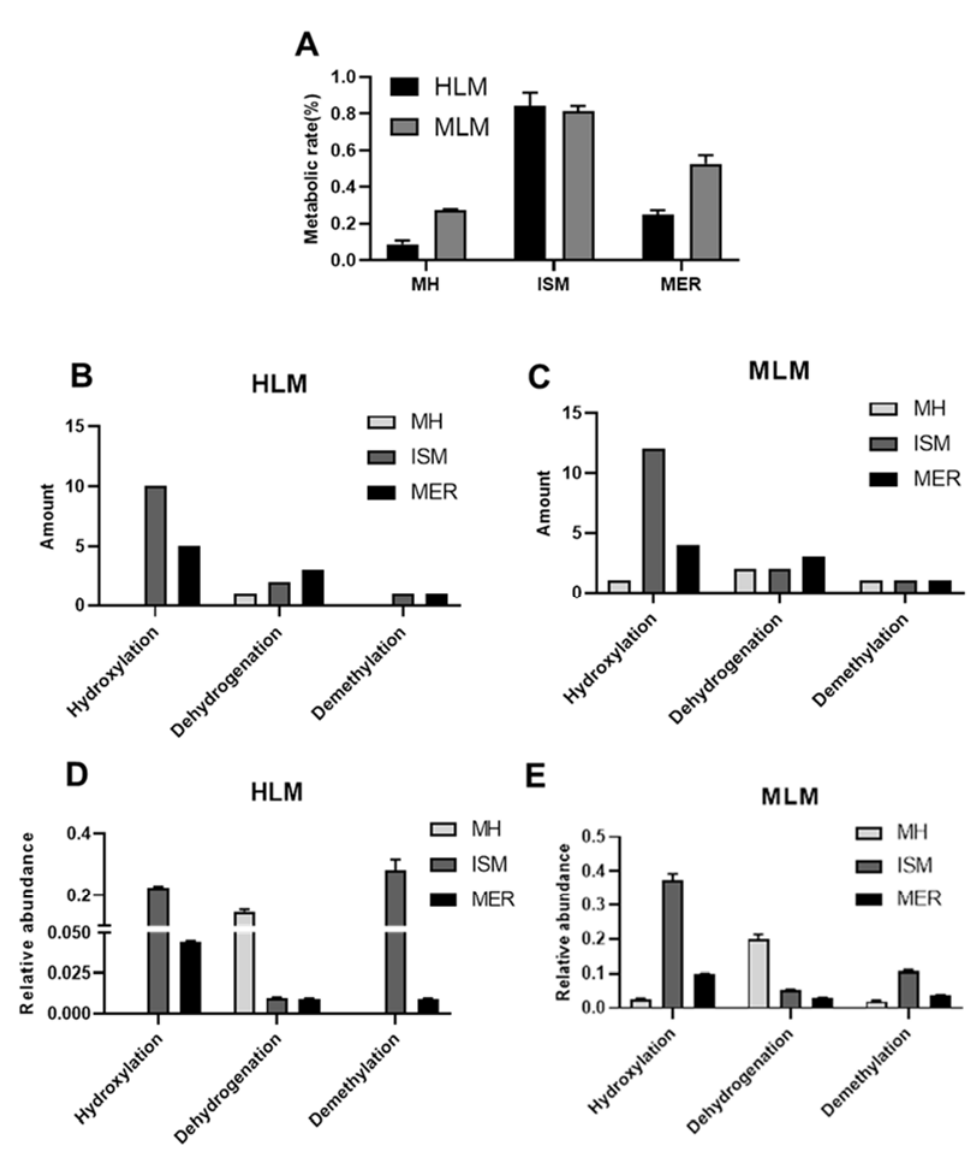
Figure 3. Metabolism of MH, ISM, and MER in liver microsome. ( A ) Metabolic rate of MH, ISM, and MER in HLM and MLM. Amount of metabolic pathways of MH, ISM, and MER in HLM ( B ) and MLM incubation systems ( C ). Relative abundance of metabolic pathways of MH, ISM, and MER in HLM ( D ) and MLM incubation systems ( E ).